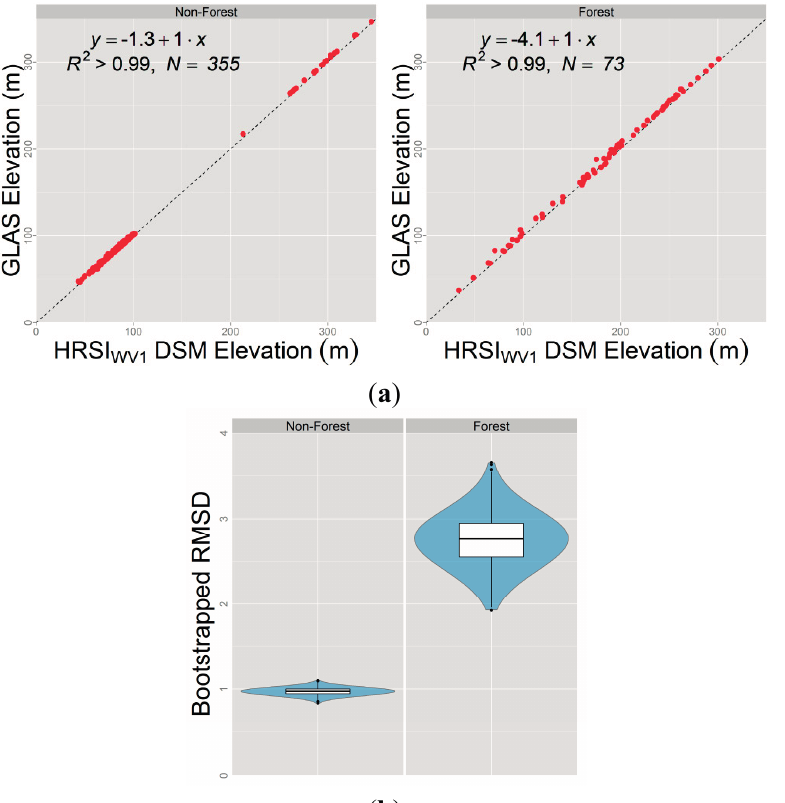
Figure 3. ( a ) The relationship of ground surface elevation measurements from GLAS and DSMs in Non-Forest and Forest cover types. The 1-to-1 line (dotted) is shown HRSI WV1 for reference; ( b ) The distributions of the bootstrapped model RMSD in ground elevation DSMs in Non-Forest (0.90 m–1.06 m, 95% CI) measurements from GLAS and HRSI WV1 and Forest (2.26 m–3.40 m, 95% CI) cover